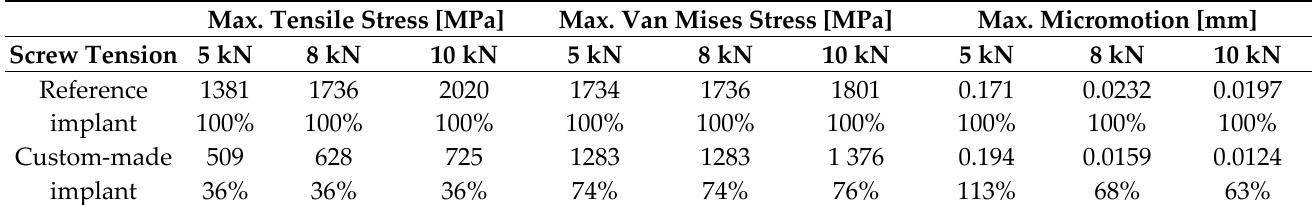
Table 2. FEA results of custom-made implant 1.